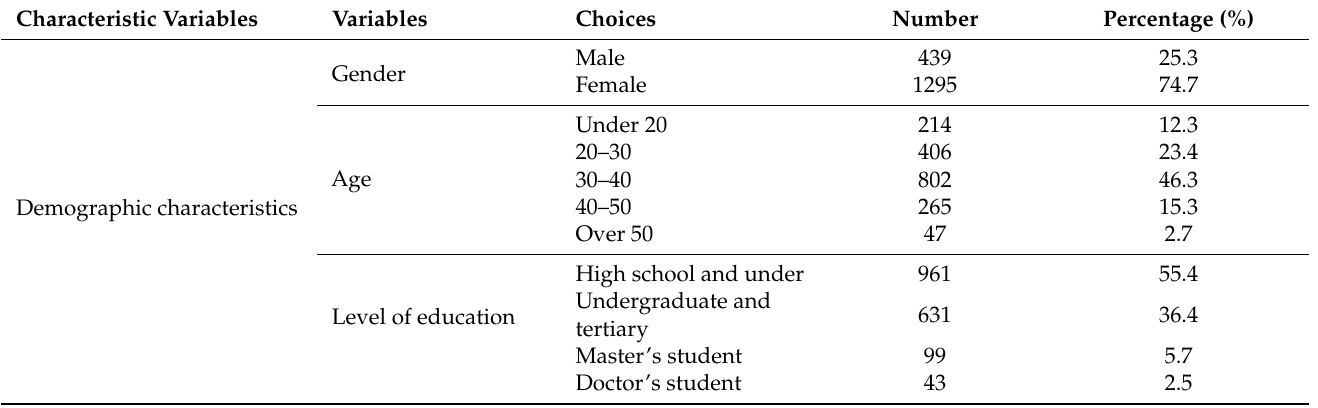
Table 3. Descriptive statistics of the